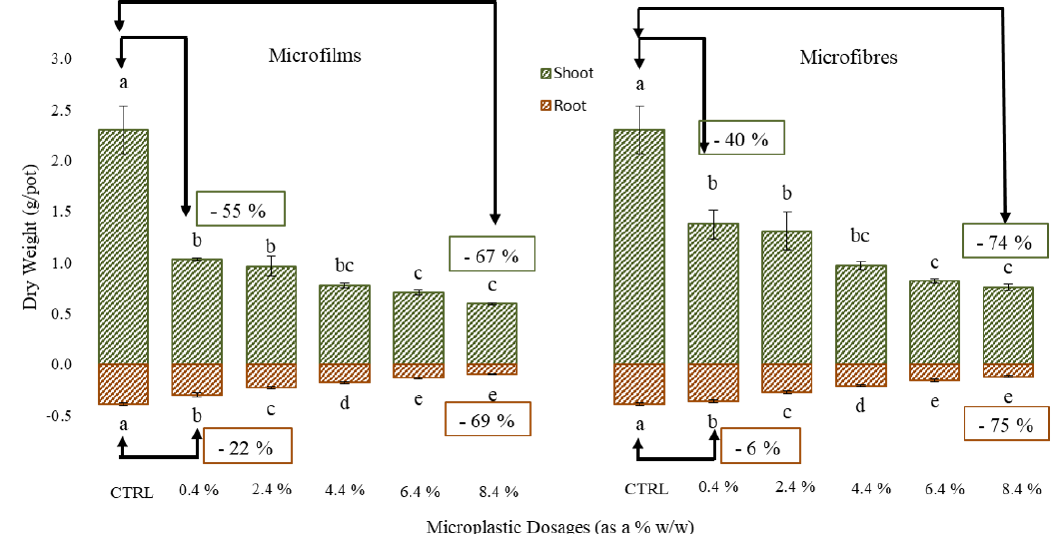
Figure 4: Dry weights (g per pot) of shoot and root of tomato plants (g/ pot) after 13 wk grown in different concentrations of microplastics (MFB and MFL) and without MPs (control). Error bars indicate the standard error of the mean value (SEM). Different letters indicate the significant differences between means at the significance level of 0.05. For clarity, the differences are shown using arrows only between the control (CTRL) and the lowest/the highest MP concentrations (0.4 and 8.4%).